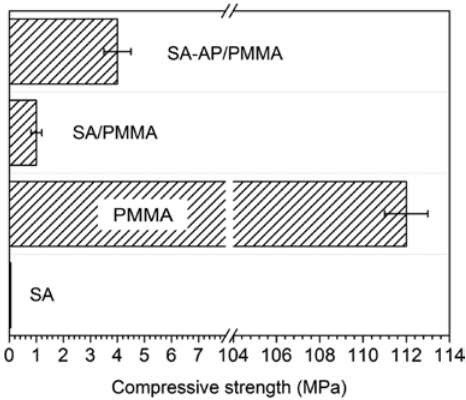
Figure 8: Mechanical properties of silica aerogel (SA), poly(methyl methacrylate) (PMMA), and composites.